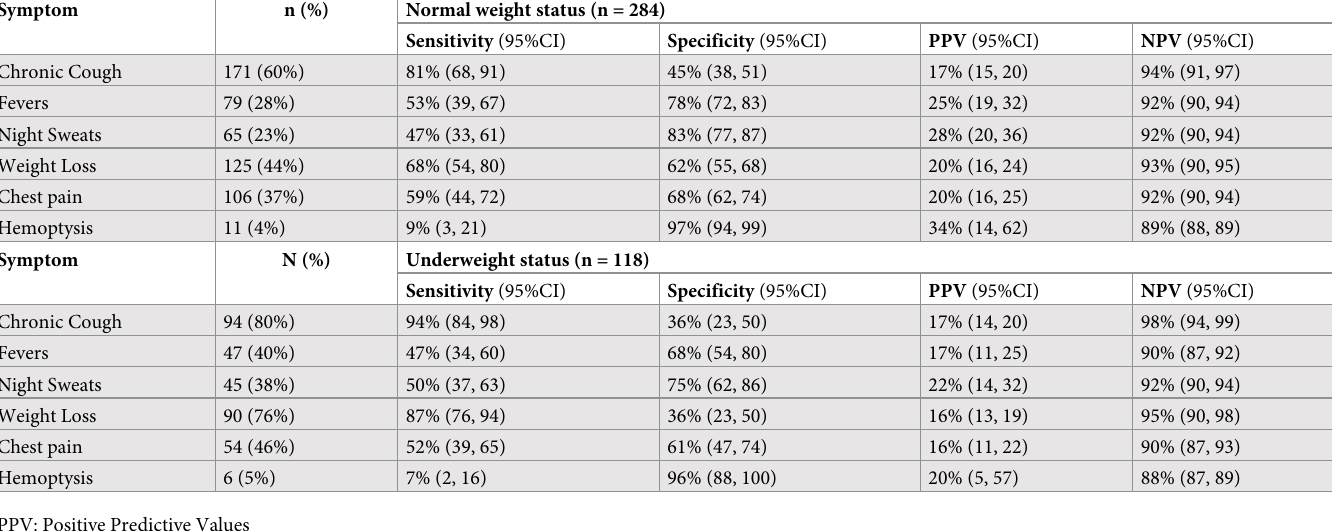
Table 2. Accuracy of individual symptoms (comparing normal and underweight status) in predicting culture-positive TB among adult presumptive at four clinics in Kampala, Uganda. (Prevalence = 12%). Symptom